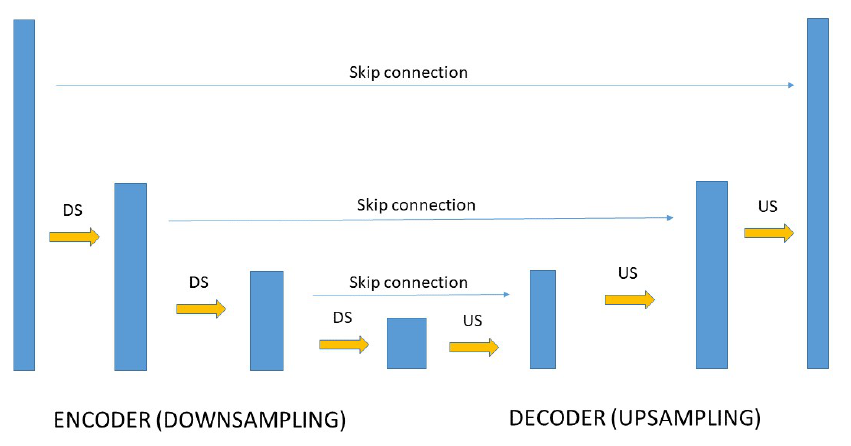
Figure 1. Illustration of the U-Net architecture, consisting of a downsampling encoder network followed by an upsampling decoder network. DS = DownSampling, US = UpSampling, blue rectangles = convolutional layers. Horizontal arrows connecting the encoder with the decoder at a particular resolution indicate skip connections, allowing for the propagation of context information from lower- to higher-resolution layers. The decoder path looks more or less symmetric with respect to the decoder path, and a U-shaped architecture is